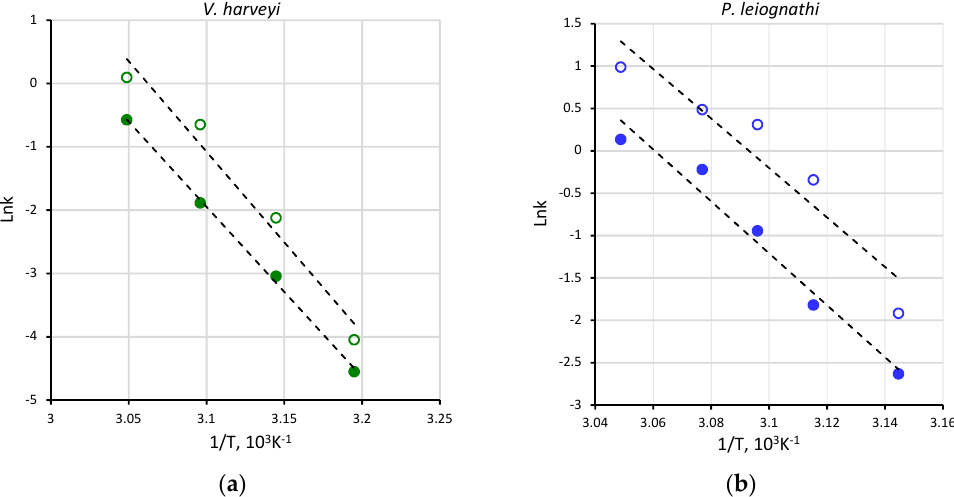
Figure 4. Arrhenius plot of the thermal inactivation of V. harveyi ( a ) and P. leiognathi ( b ) luciferases in the buffer (empty circles) and sucrose solution (filled circles). The k is the enzyme thermal inactivation rate constant at each respective temperature, taken from Table 1. Dashed lines refer to a linear approximation.